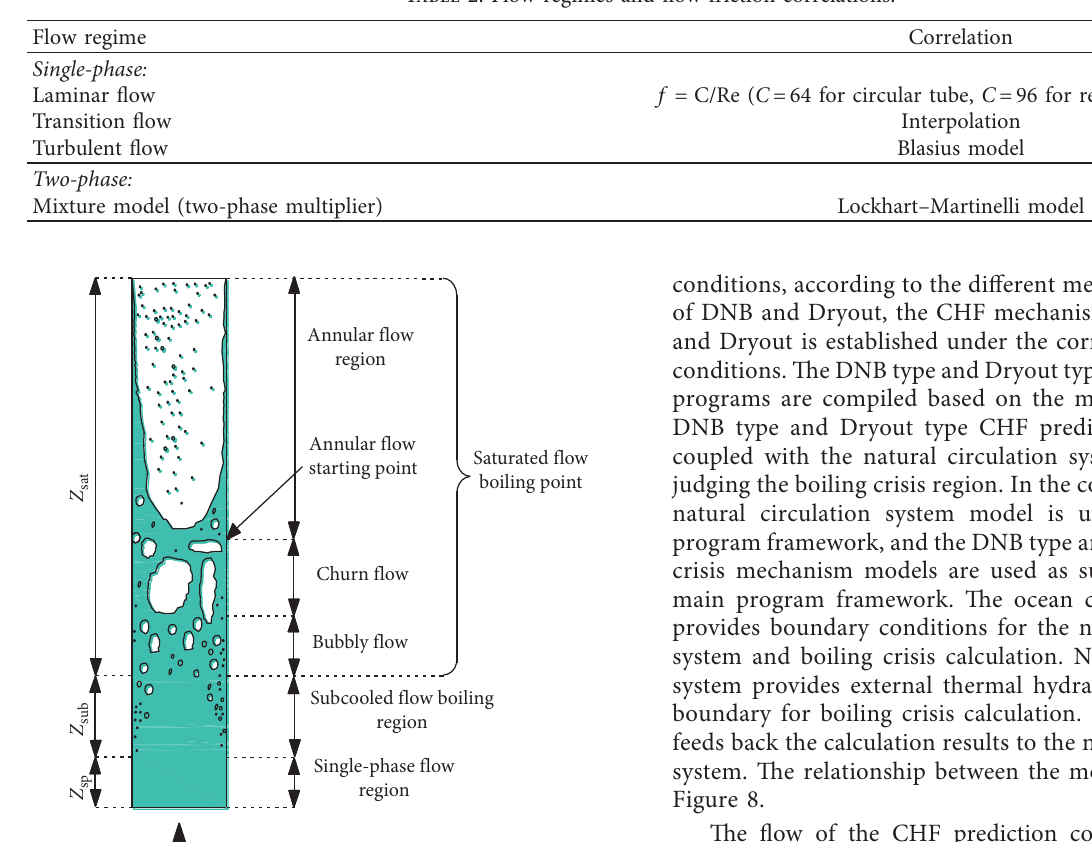
Table 2: Flow regimes and flow friction correlations.